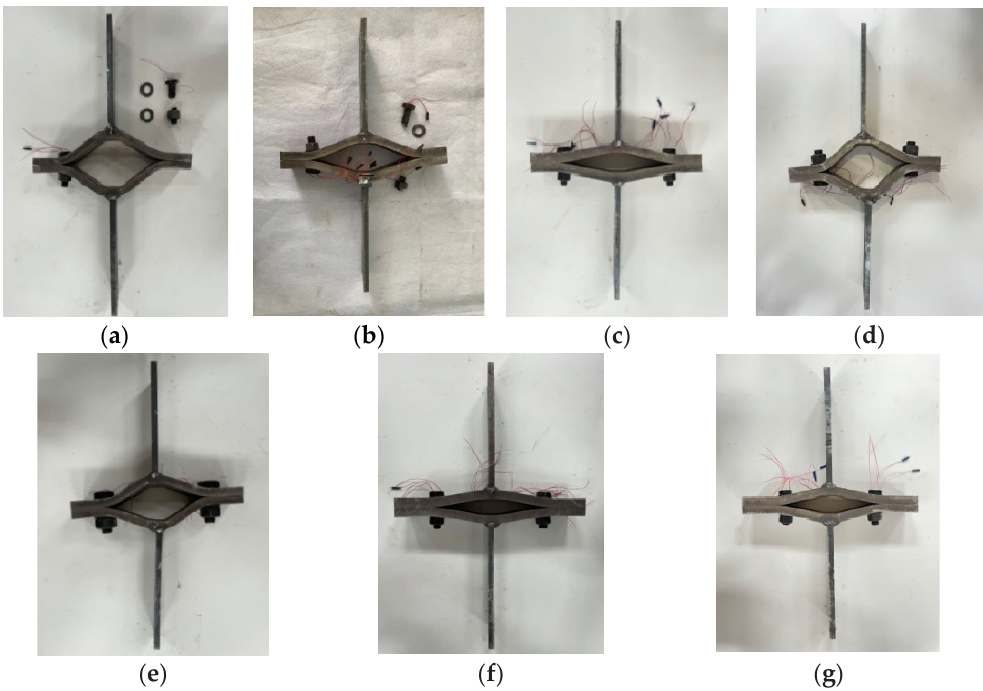
Figure 7. Post-test (failed) specimens—see Table 4 for the classification of their failure mode. ( a ) D14, ( b ) D16, ( c ) D18, ( d ) M20, ( e ) M24, ( f ) S70, ( g ) S80. ( b ) D16, ( c ) D18, ( d ) M20, ( e ) M24, ( f ) S70, ( g ) S80.